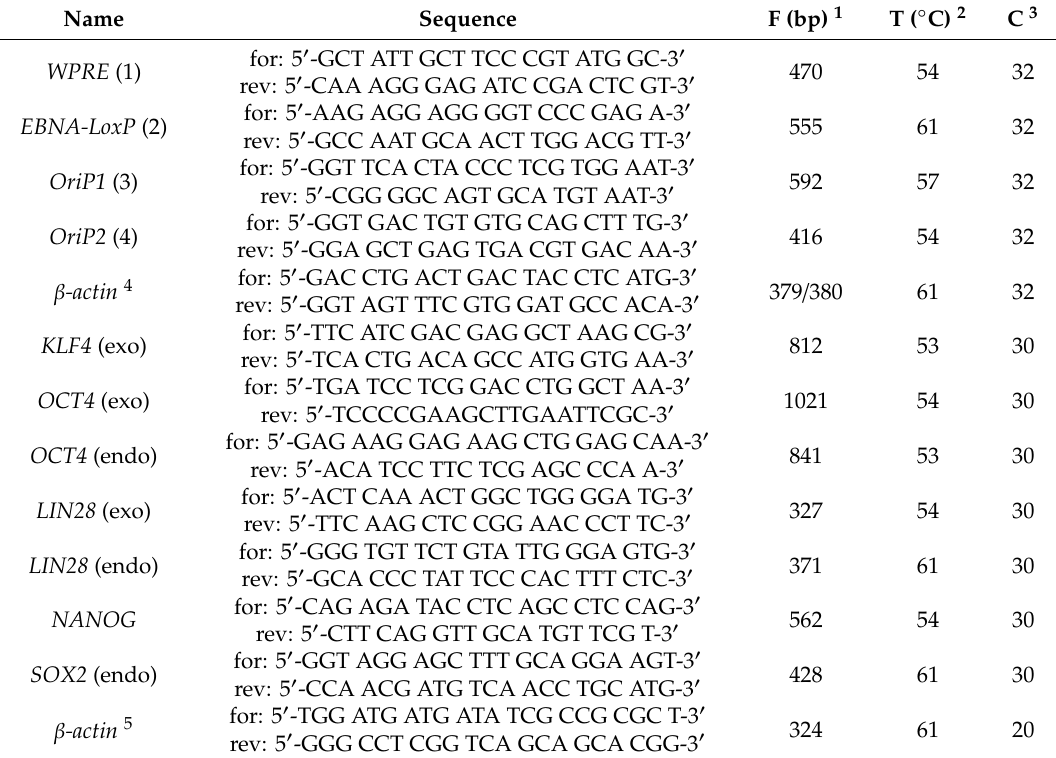
Table 3. Oligonucleotides used in this